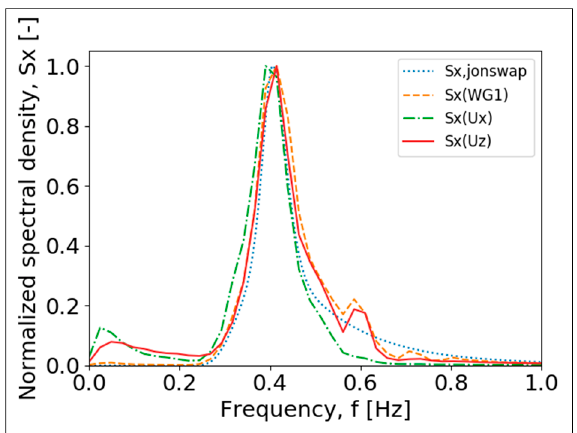
Figure 16. Normalized spectral density of target JONSWAP, Sx, jonswap, measurements of water level, Sx (WG1), and ADV velocity measurements (ADV2) x-components, Sx ( Ux ), and z-components, Sx ( Uz ), over the frequency.